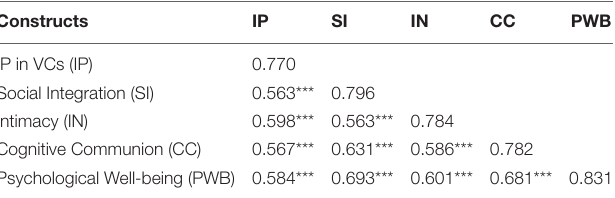
TABLE 4 | Correlations between latent constructs.